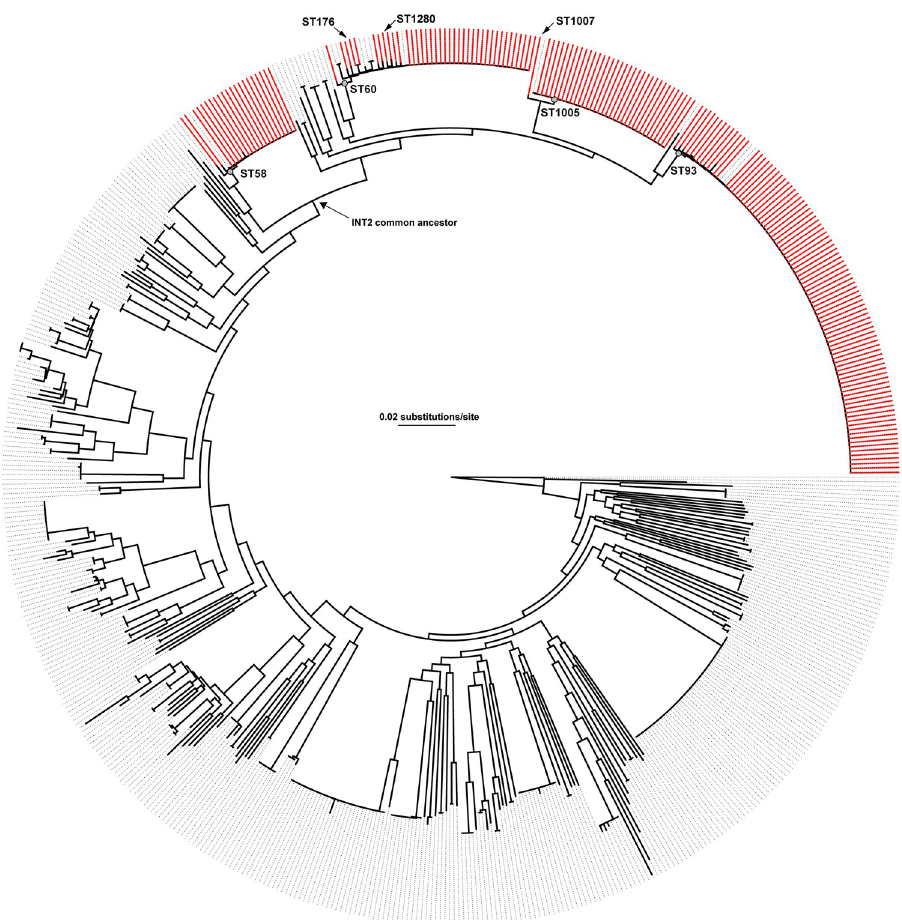
Fig 2. An approximate maximum-likelihood phylogenetic tree inferred with FastTree2 [45] from a concatenation of 90,518 core genome SNPs called from 169 genomes sequenced in this study (red text) as well as 1,576 reference B . pseudomallei genomes from GenBank (S2 Table). Genomes sequenced in this study are shown in red. The tree was rooted with MSHR668 based on its basal position in other studies [71].